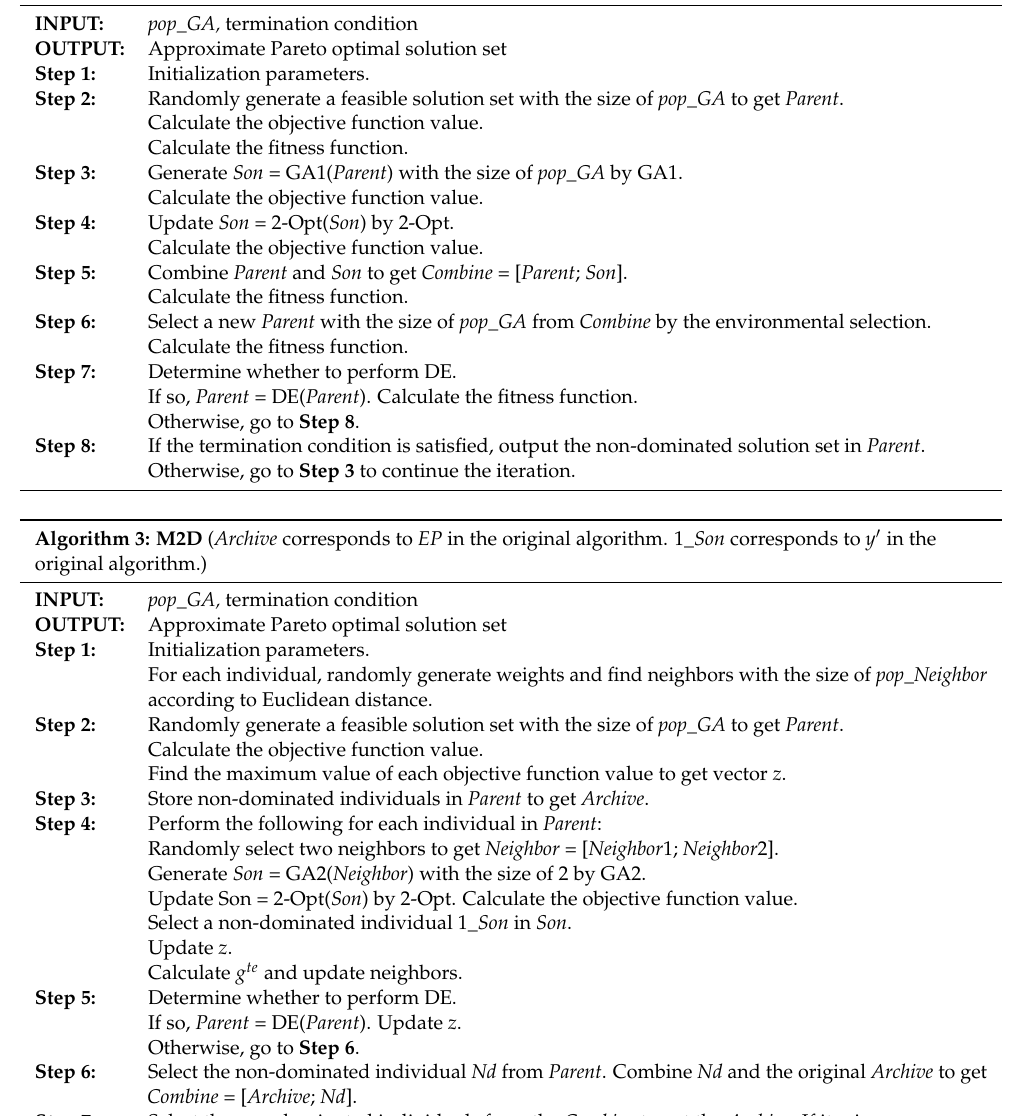
Algorithm 2: S2D (In this article, Parent corresponds to P t in the original algorithm. Son corresponds to P t in the original algorithm.)